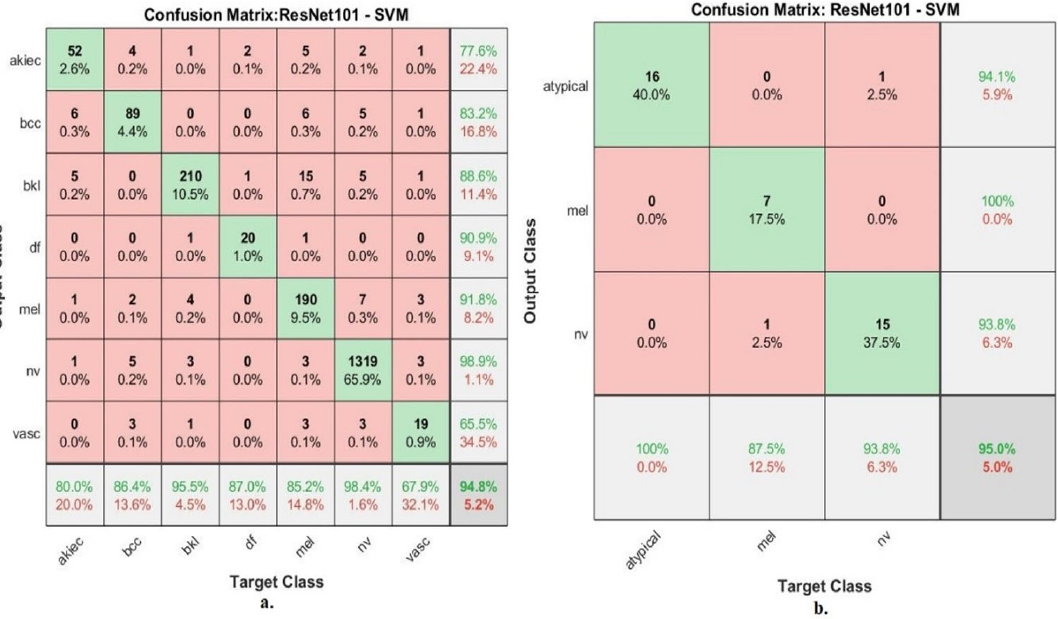
Figure 12. Confusion matrix for the classification of two skin lesion datasets by SVM with ResNet101 features through datasets of ( a ) HAM10000 and ( b ) PH2.